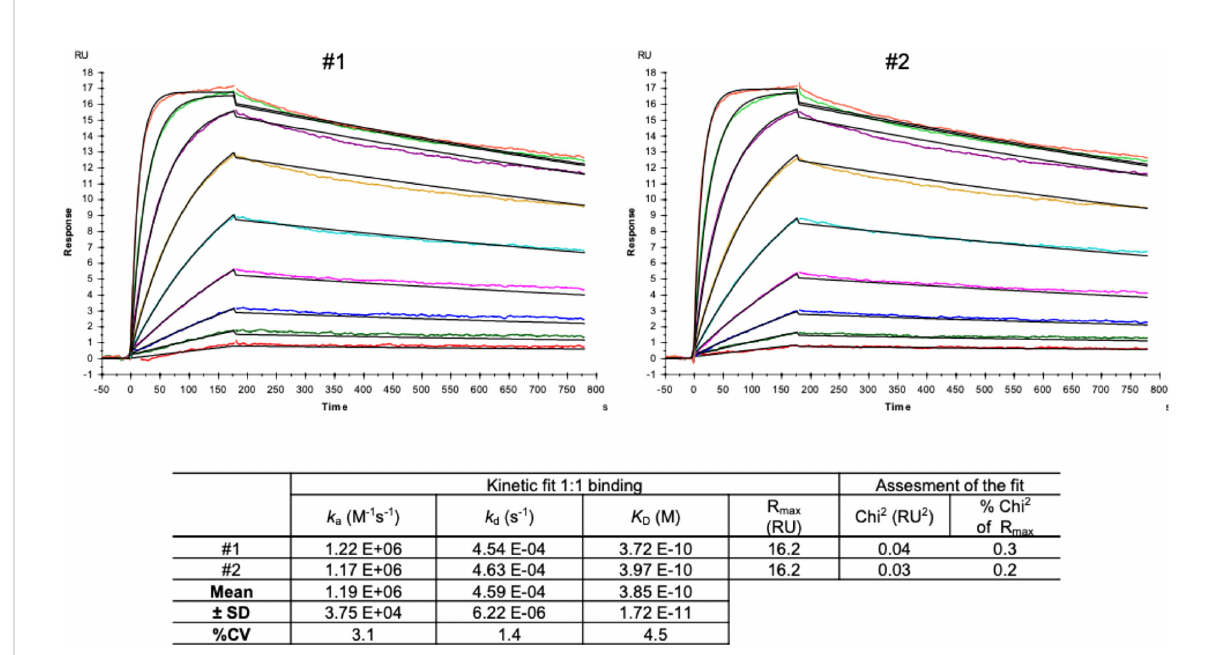
FIGURE 5 SPR measurements of hcAb B10. SARS-CoV-2 Spike protein-RBD-mFc (Acrobiosystem; SPD-C5259) was used as antigen and captured by a covalently immobilized anti-IgG1 antibody on a C1 sensor chip. Increasing concentrations of hcAb B10 (0.23 - 60 nM) were injected. Analyte responses were corrected for unspeci fi c binding and buffer responses. The sensograms were fi tted with a monovalent binding model using Biacore evaluation